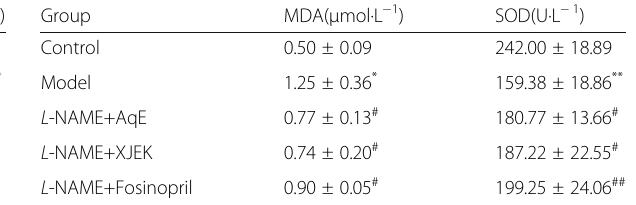
Table 4 Effects of AqE on endothelial dysfunction in L -NAME induced hypertensive mice Group